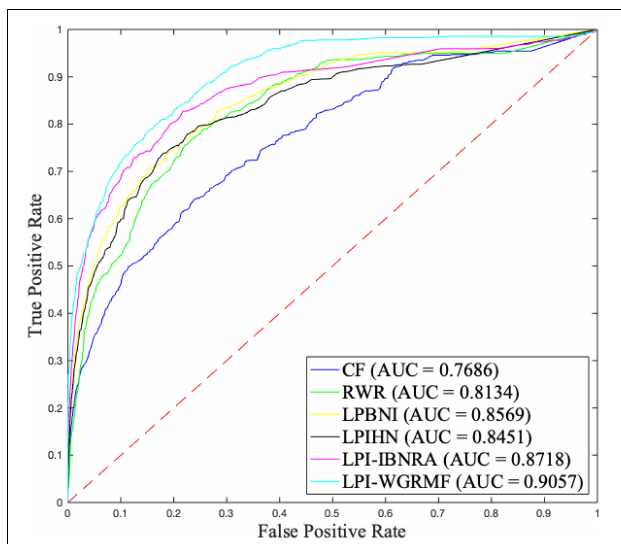
FIGURE 1 | The AUC values of six LPI prediction methods.